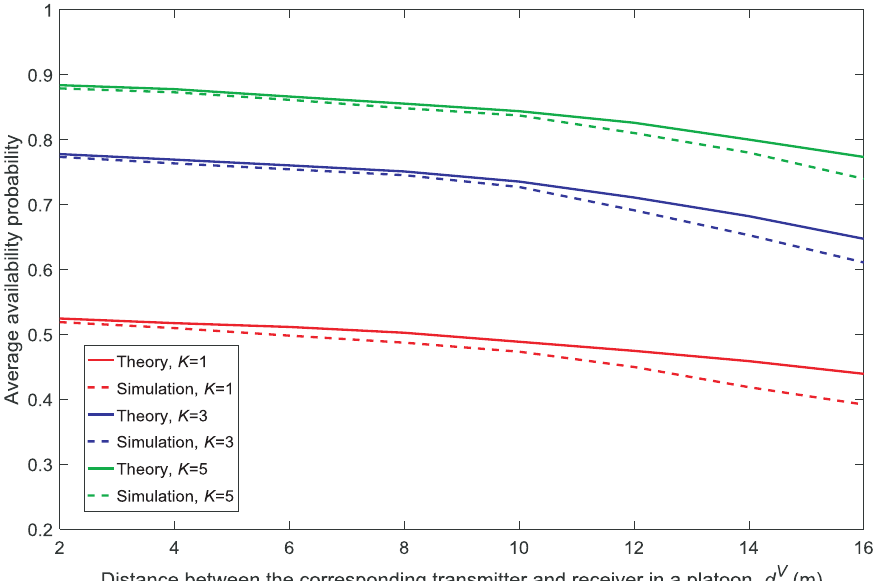
Figure 4. Average availability probability for different distances between the corresponding transmitter and receiver in a platoon d V ( λ = 1/1000, V = 10, N = 5 )